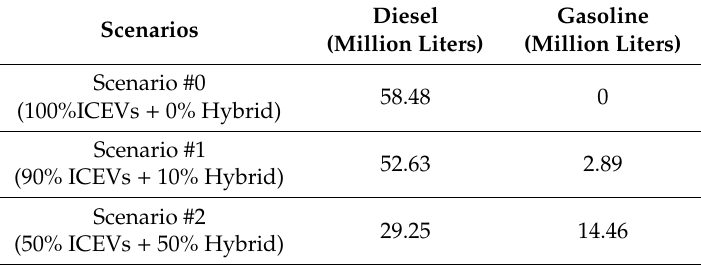
Table 2. Expected total consumed fuels by taxis in 2030.